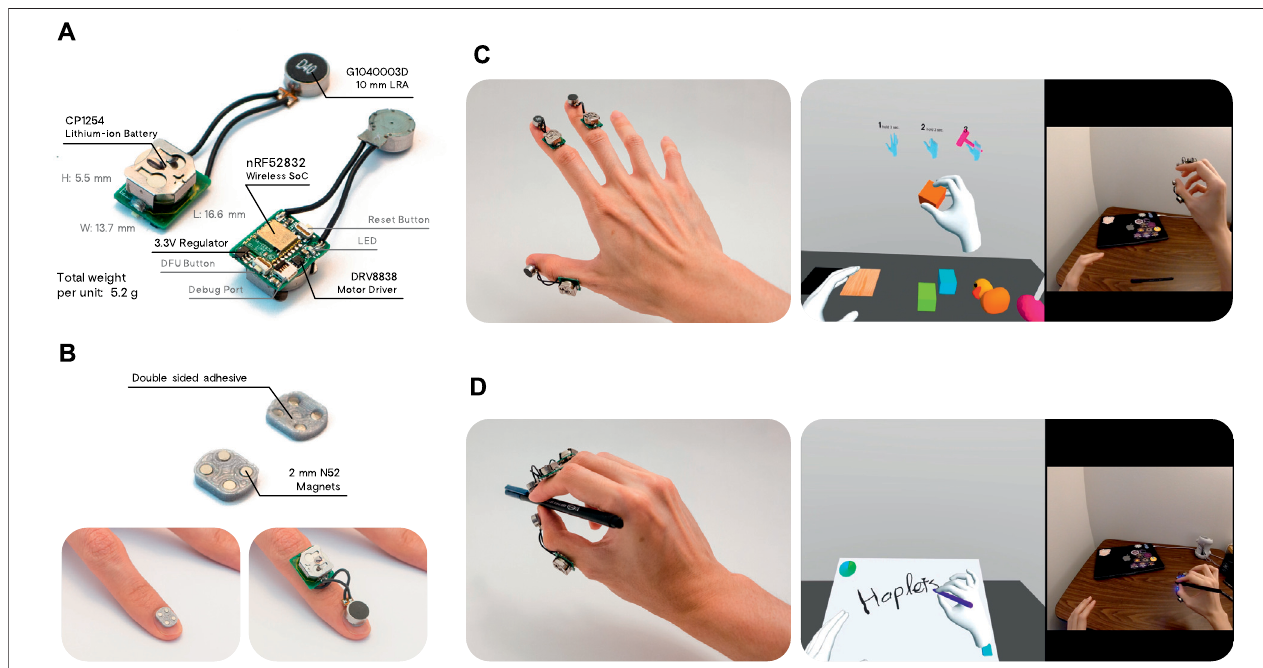
FIGURE 1 | An overview of Haplets. (A) Components comprising of a Haplet unit is shown, including the three key elements: the wireless SoC, the LRA, and the built-in battery. (B) Haplets are attached on the fi ngernails through fi ngernail-mounted magnets. The magnets are embedded in a plastic housing that is attached to the fi ngernailusingdouble-sidedadhesive. (C) TheuserwearsHapletsonthethumb,theindex fi ngerandthemiddle fi nger.Anexampleofamanipulationscenarioasseenin VRcomparedtothereal-worldisshown. (D) Whenusedwithatool(apen,asshown),HapletscanbeusedtoaugmentthevirtualrepresentationofthetoolinVRby providing vibrotactile feedback in addition to the passive haptic feedback provided by the fi nger ’ s grounding on the